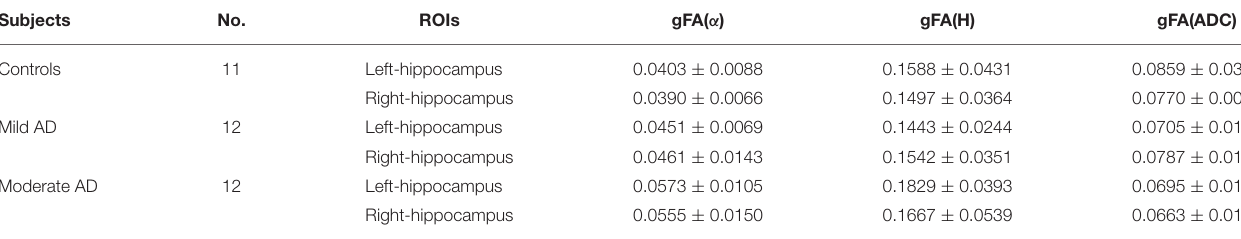
TABLE 2 | Mean and SD of the gFA( α ), gFA( H ), and gFA(ADC) values of left and right hippocampus in all participants.